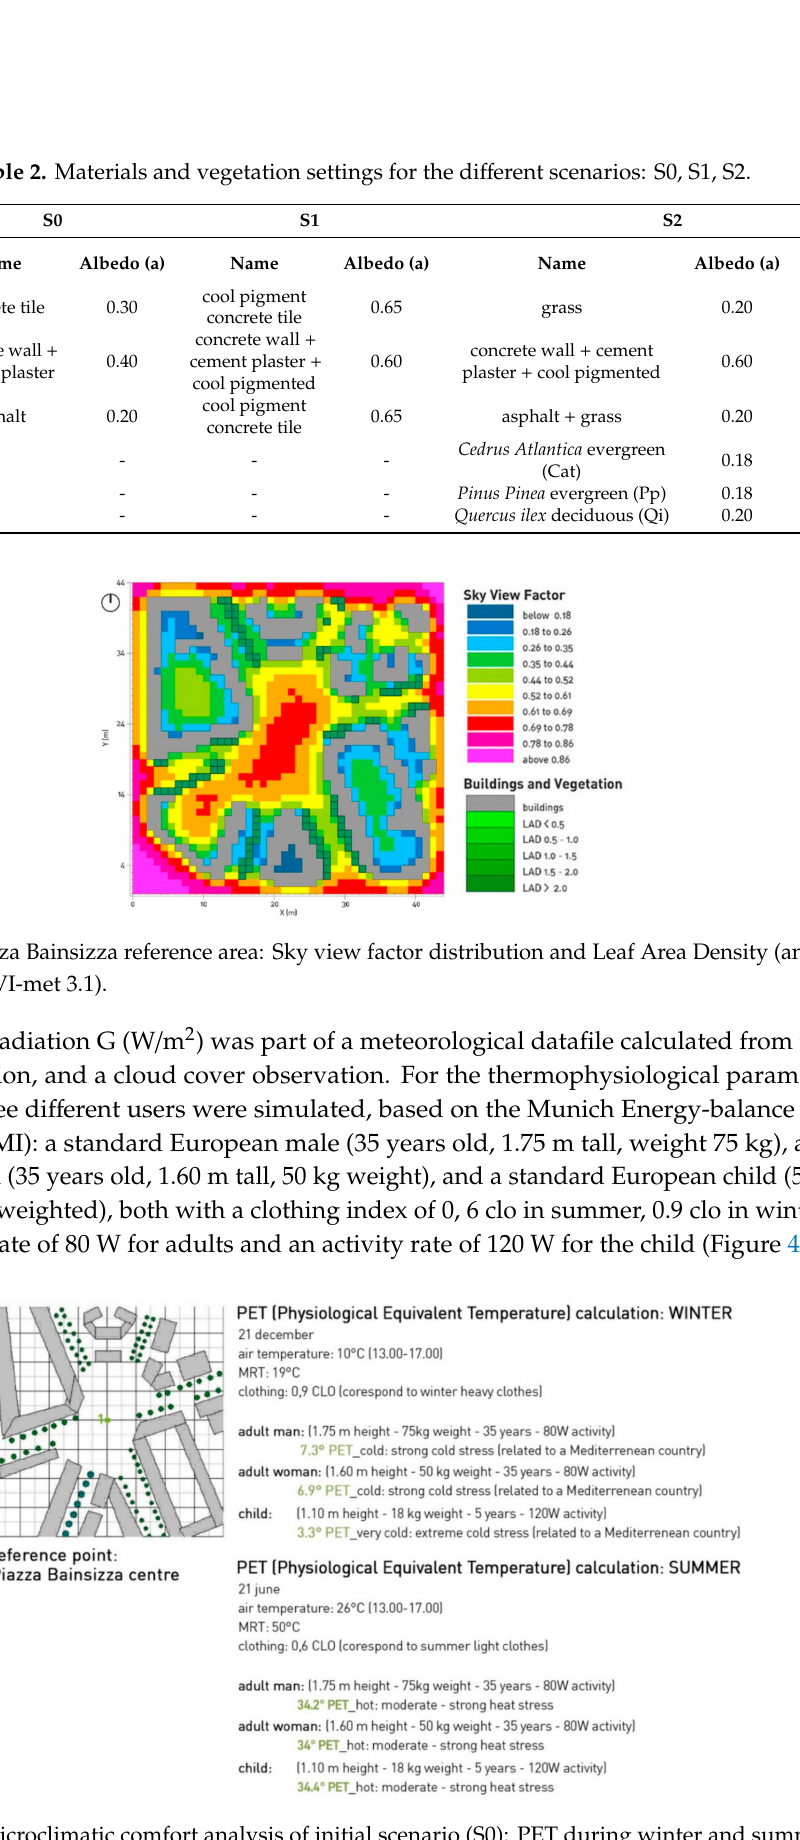
Figure 4. Microclimatic comfort analysis of initial scenario (S0): PET during winter and